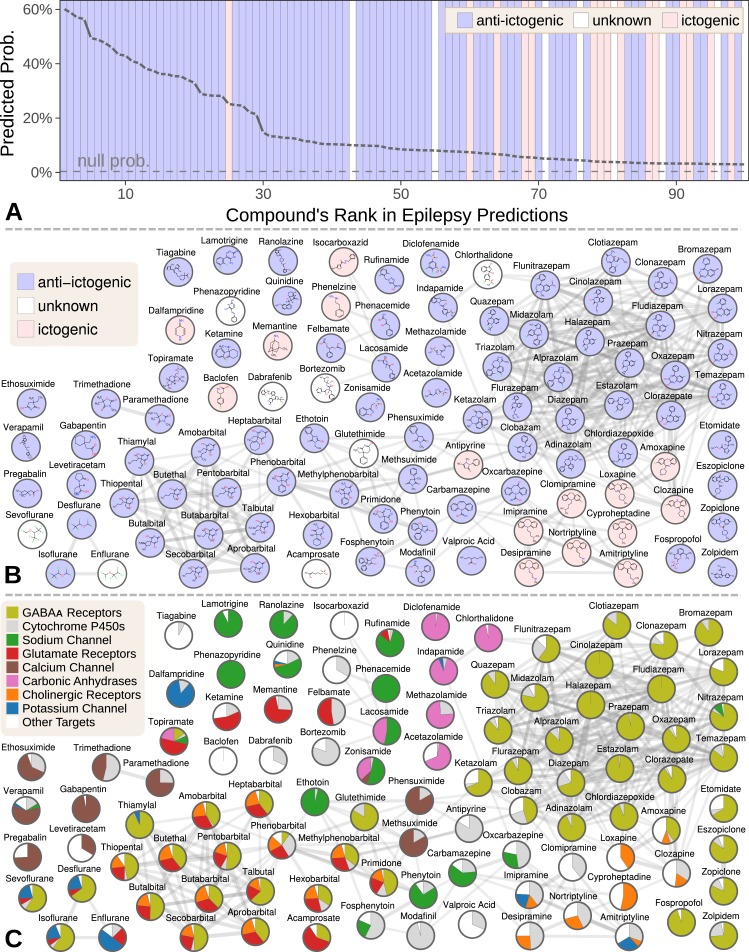
Top 100 epilepsy predictions.(A) Compounds — ranked from 1 to 100 by their predicted probability of treating epilepsy — are colored by their effect on seizures (Khankhanian and Himmelstein, 2016). The highest predictions are almost exclusively anti-ictogenic. Further down the prediction list, the prevalence of drugs with an ictogenic (contraindication) or unknown (novel repurposing candidate) effect on epilepsy increases. All compounds shown received probabilities far exceeding the null probability of treatment (0.36%). (B) A chemical similarity network of the epilepsy predictions, with each compound’s 2D structure (Himmelstein et al., 2017a). Edges are Compound–resembles–Compound relationships from Hetionet v1.0. Nodes are colored by their effect on seizures. (C) The relative contribution of important drug targets to each epilepsy prediction (Himmelstein et al., 2017a). Specifically, pie charts show how the eight most-supportive drug targets across all 100 epilepsy predictions contribute to individual predictions. Other Targets represents the aggregate contribution of all targets not listed. The network layout is identical to B.